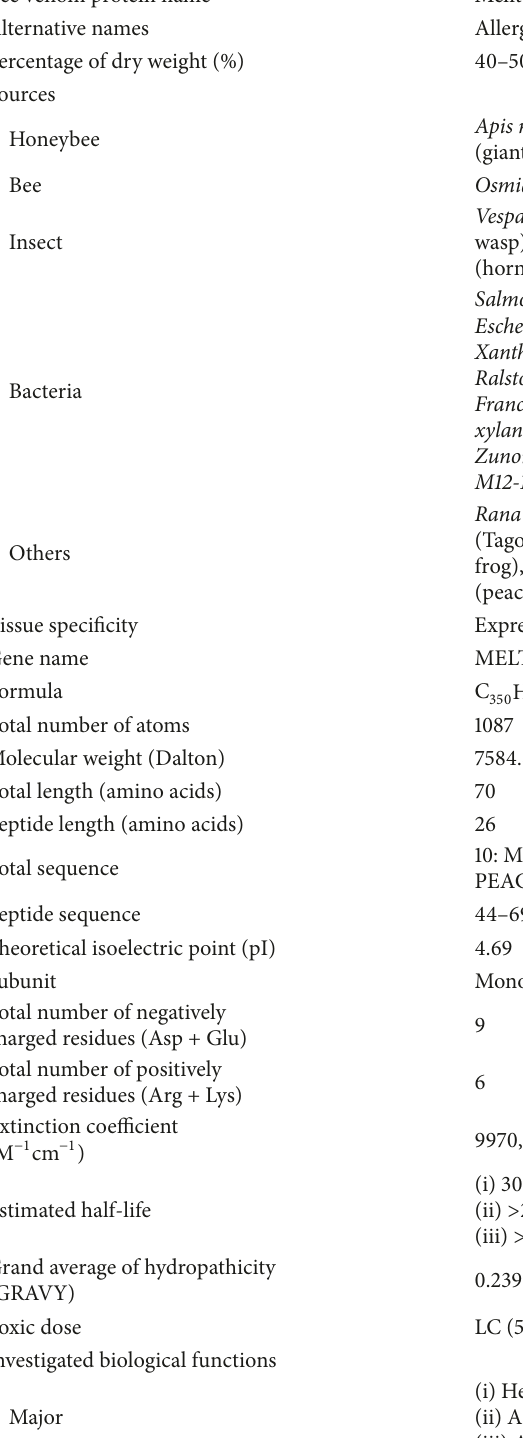
Table 1: Principal honeybee protein